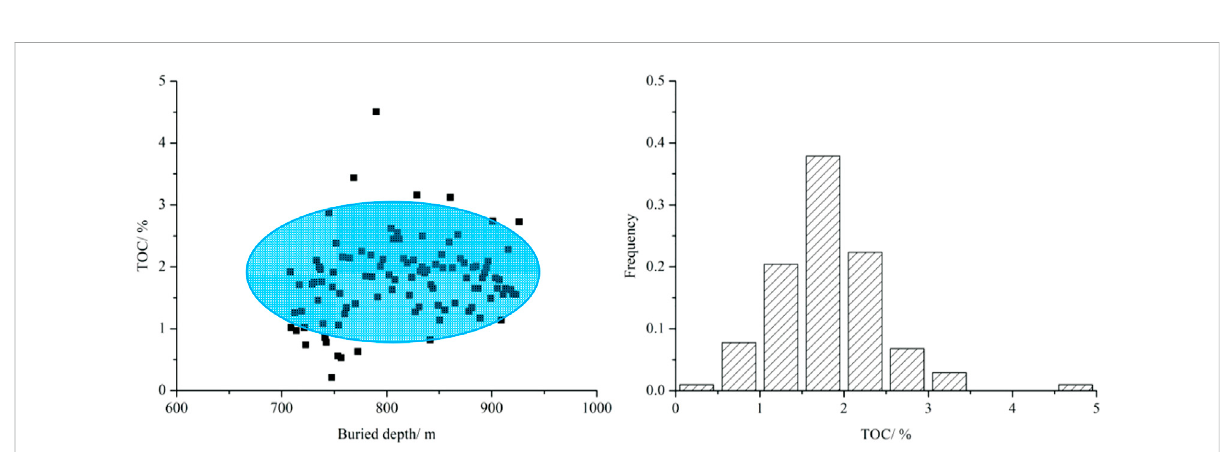
FIGURE 4 TOC variation with depth (left) and TOC frequency histogram (right) for well